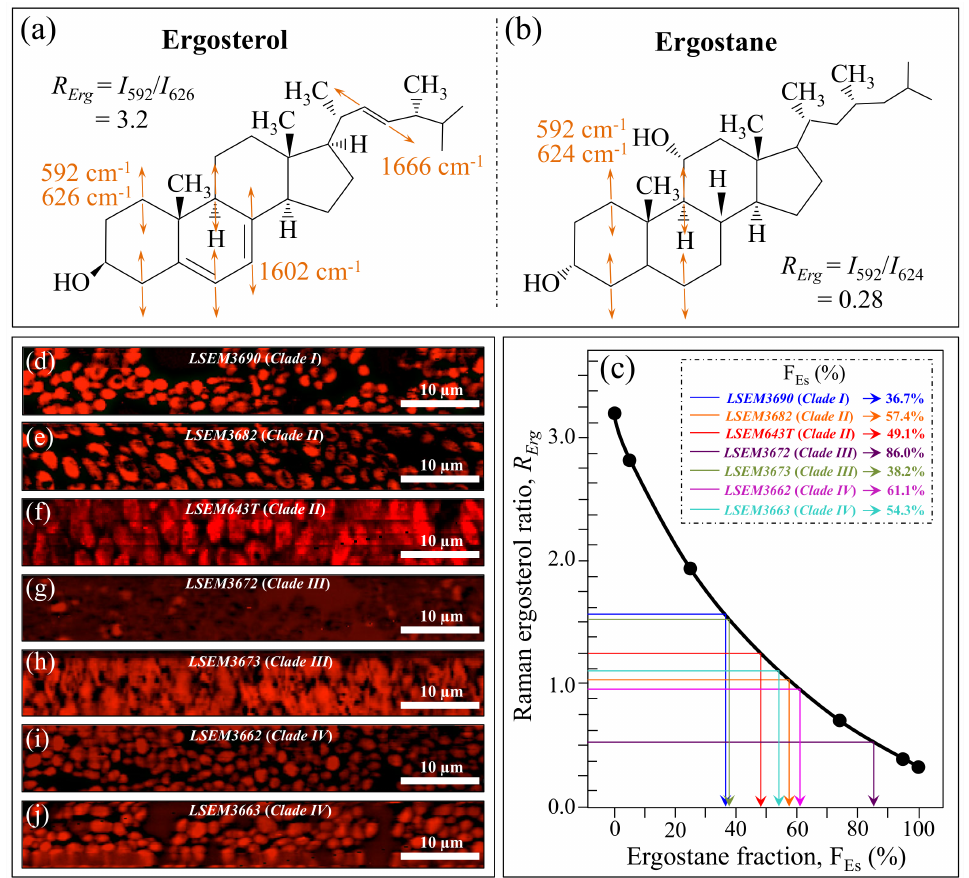
Figure 9. Molecular structure of ( a ) ergosterol and ( b ) ergostane (with the respective Raman fin- gerprint vibrations); ( c ) Raman calibration plot of the R Erg = I 597 / I 620 intensity ratio vs. ergostane fraction, F Es (built from data in Ref. [61]); ( d – j ): Raman images of the R Erg ratio collected on different C. auris samples (cf. labels). The average R Erg value for each image locates the respective F Es value on the calibration plot ( c ) (cf. values shown in inset given in